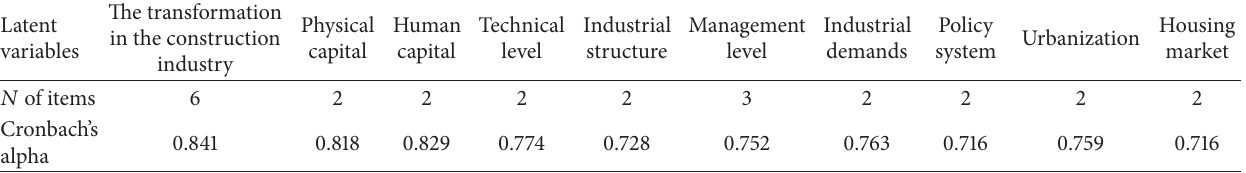
Table 3: Latent variables reliability